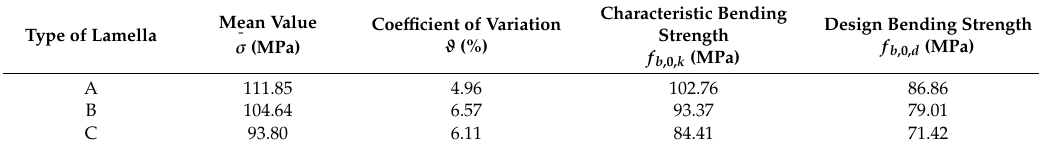
Table 2. Calculated values of flat lamella.